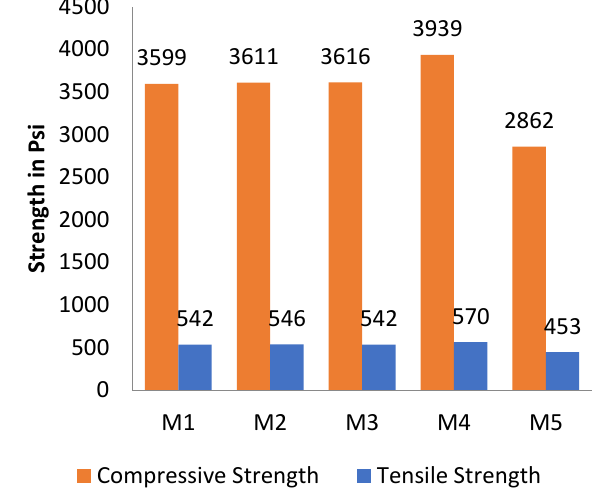
Fig.14. Compressive and tensile splitting